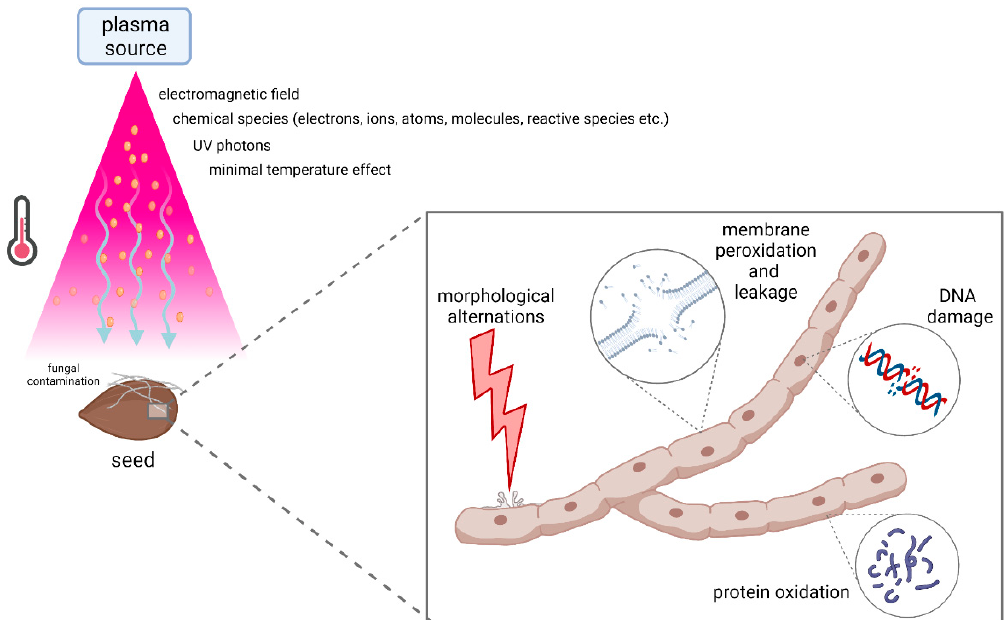
Figure 3. Main agents and mechanisms governing fungal decontamination in cold plasma sterilization process. This image was created with